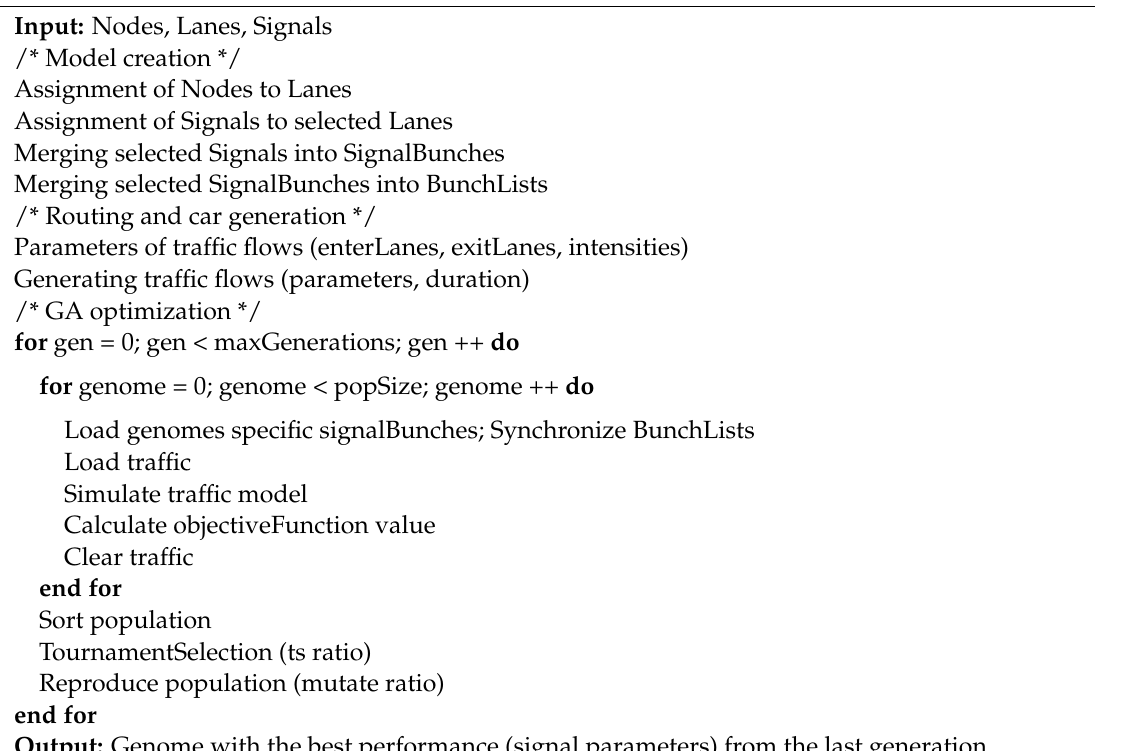
Algorithm 1 Optimization via a genetic algorithm (GA)